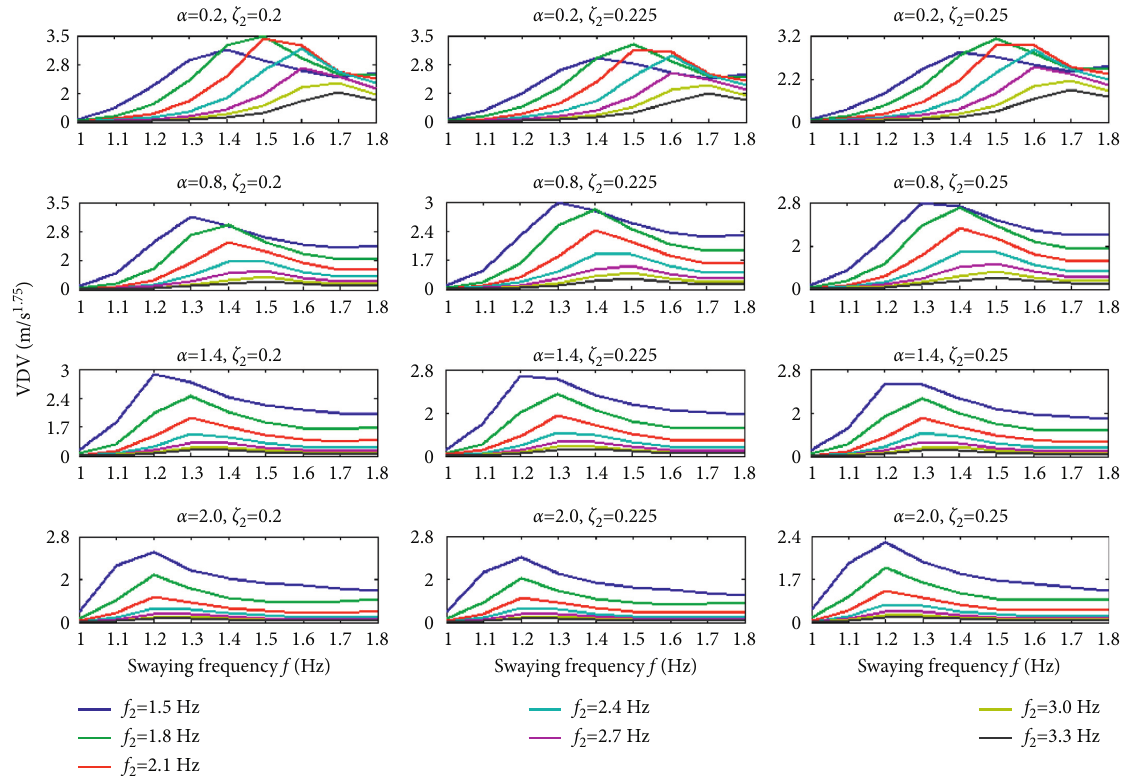
Figure 15: The structural dynamic responses with VDV values.